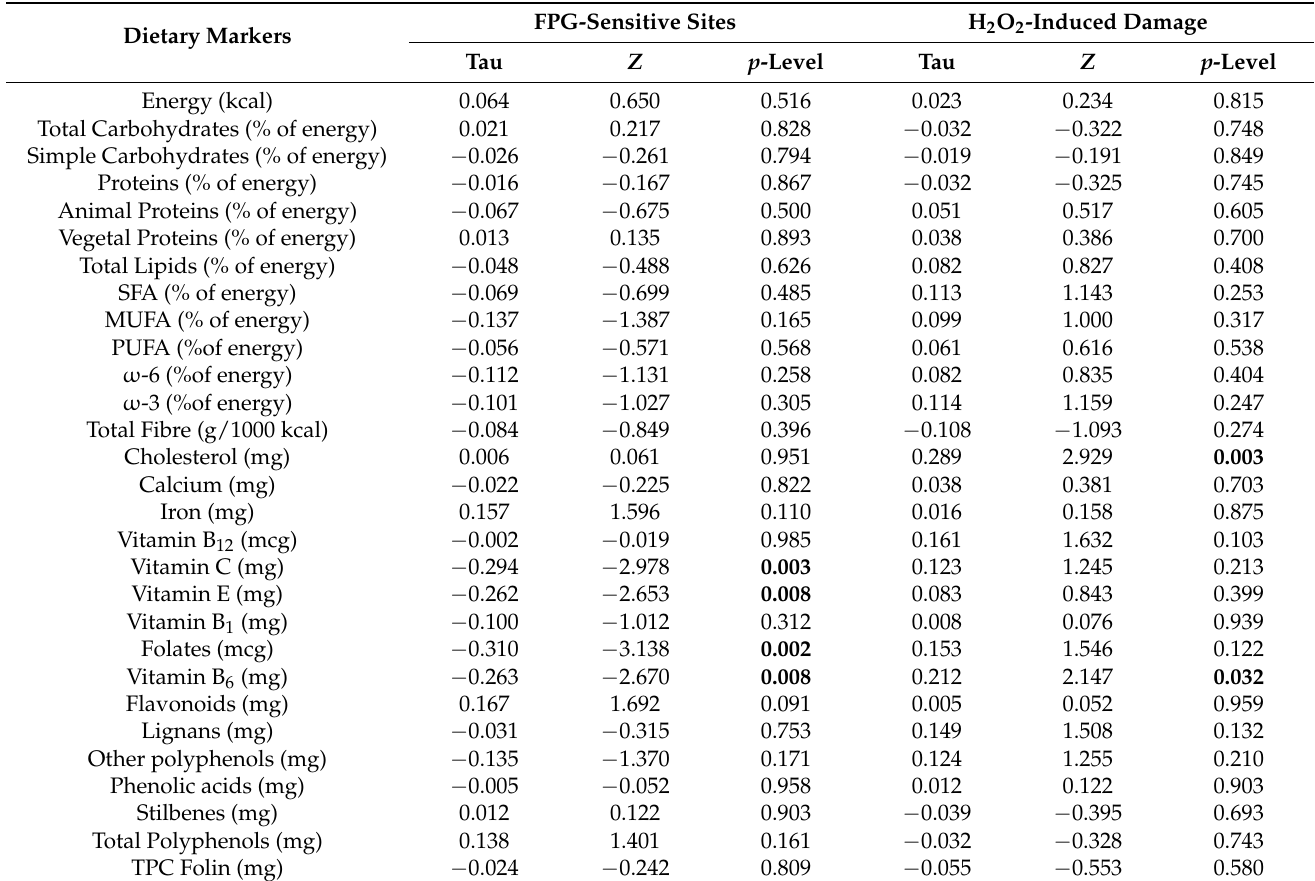
Table 2. Correlation analysis between dietary markers and DNA damage in the whole group of subjects. FPG-Sensitive Dietary Markers